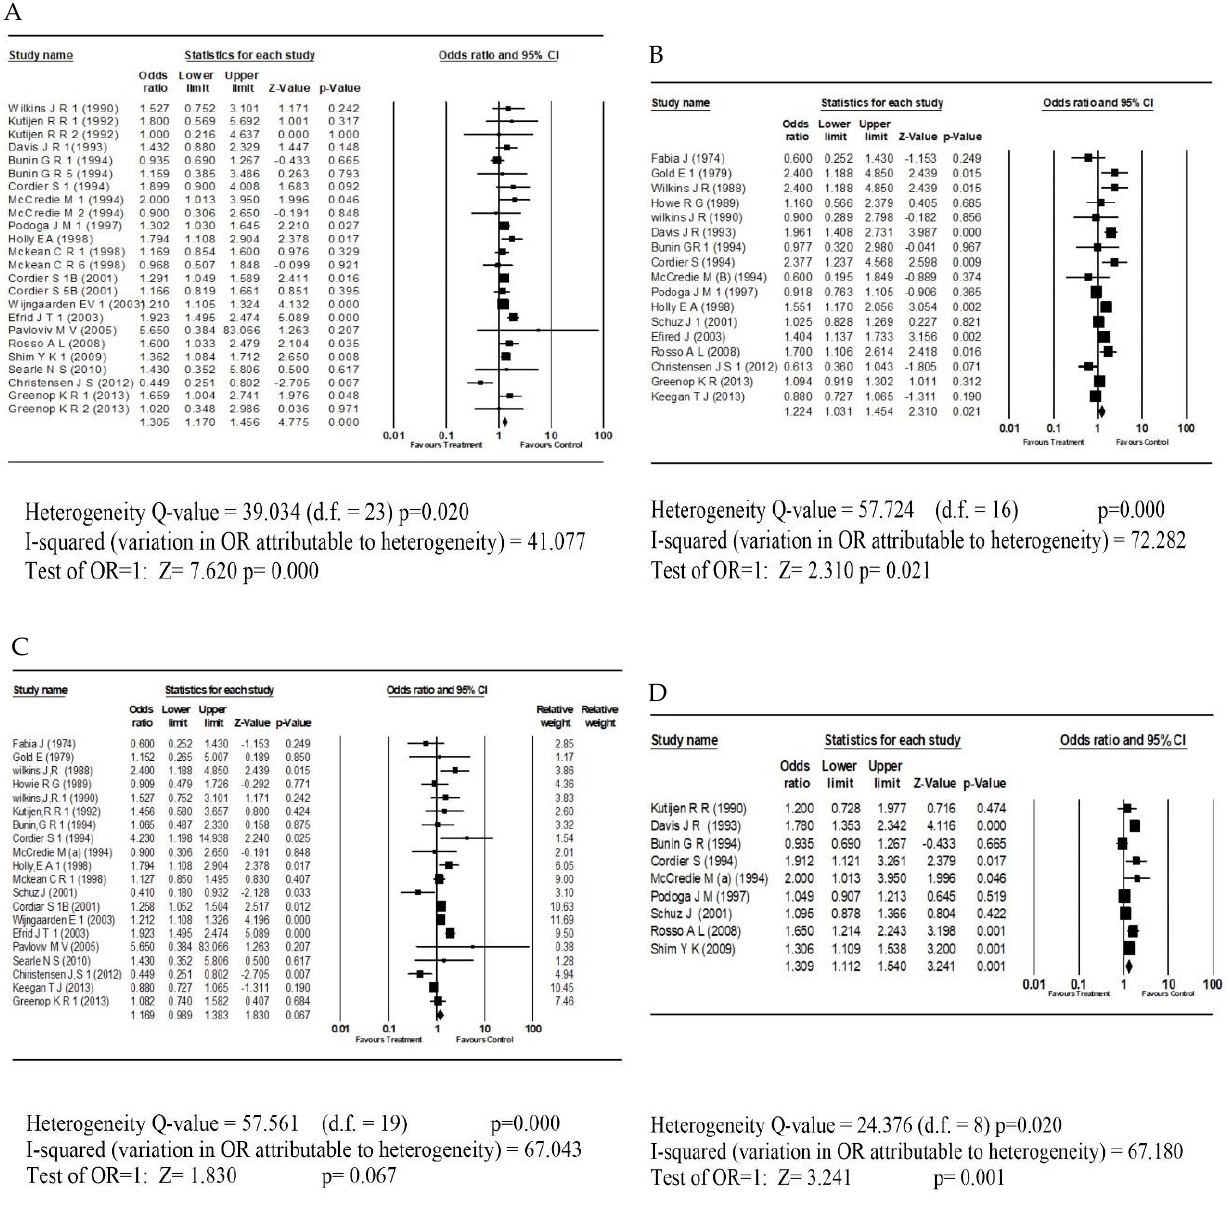
Figure 2. Forest plot displaying a meta-analysis of the effect of pesticides on Child Brain: ( A ) (upper Left) = Before birth; ( B ) (upper right) = After Birth; ( C ) (lower left) =Occupational Exposure; ( D ) (lower right) = Residential Exposure.